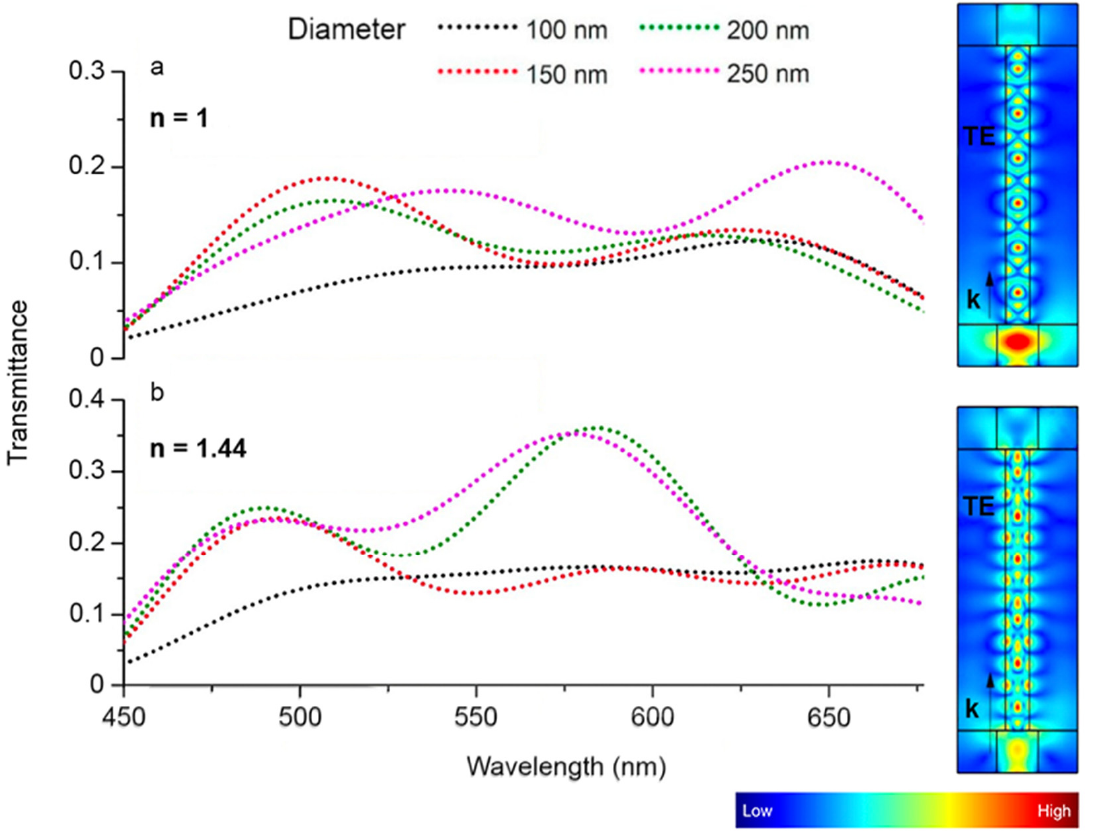
Figure 2. Transmission spectra of 2 µm long GaP NW having diameter of 100–250 nm in different media: ( a ) air and ( b ) refractive index of n = 1.44. Inset demonstrates normalized electric field distribution in 200 nm diameter NW excited by λ = 532 nm.